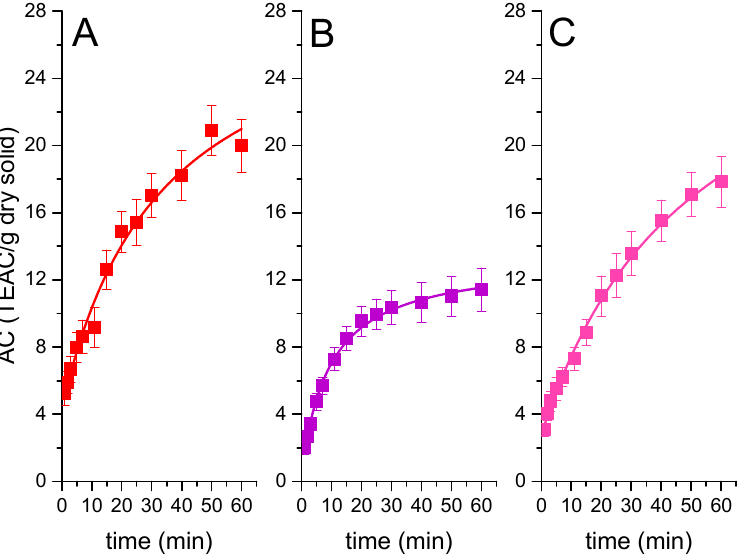
Figure 5. Kinetic analysis of the extraction processes of AP employing ( A ) acetone at 25 ◦ C, ( B ) acetone/water 80%/20% v/v at 25 ◦ C, ( C ) water at 25 ◦ C, and ( D ) ethanol 96% at 70 ◦ C: antioxidant activity as obtained by DPPH method. Kinetic model fitting is presented in lines.